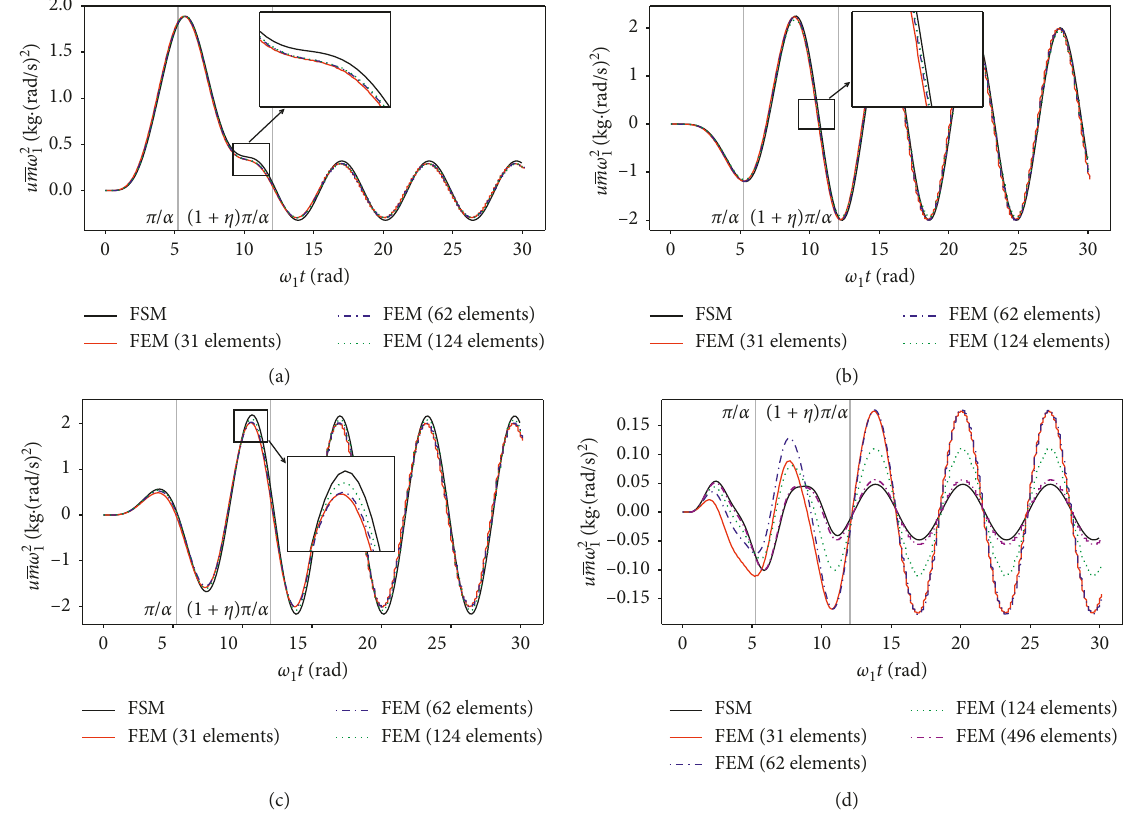
Figure 3: Comparisons of dynamic responses of the simply supported beam obtained by FSM and FEM ( η for the time that the whole length of beam is subjected to the distributed force; have departed from the beam, which will vibrate freely later). (a) Displacement of beam u 1 due to f 1 . (b) Displacement of beam u 3 n due to f 3 n ( n (cid:30) 1). (c) Displacement of beam